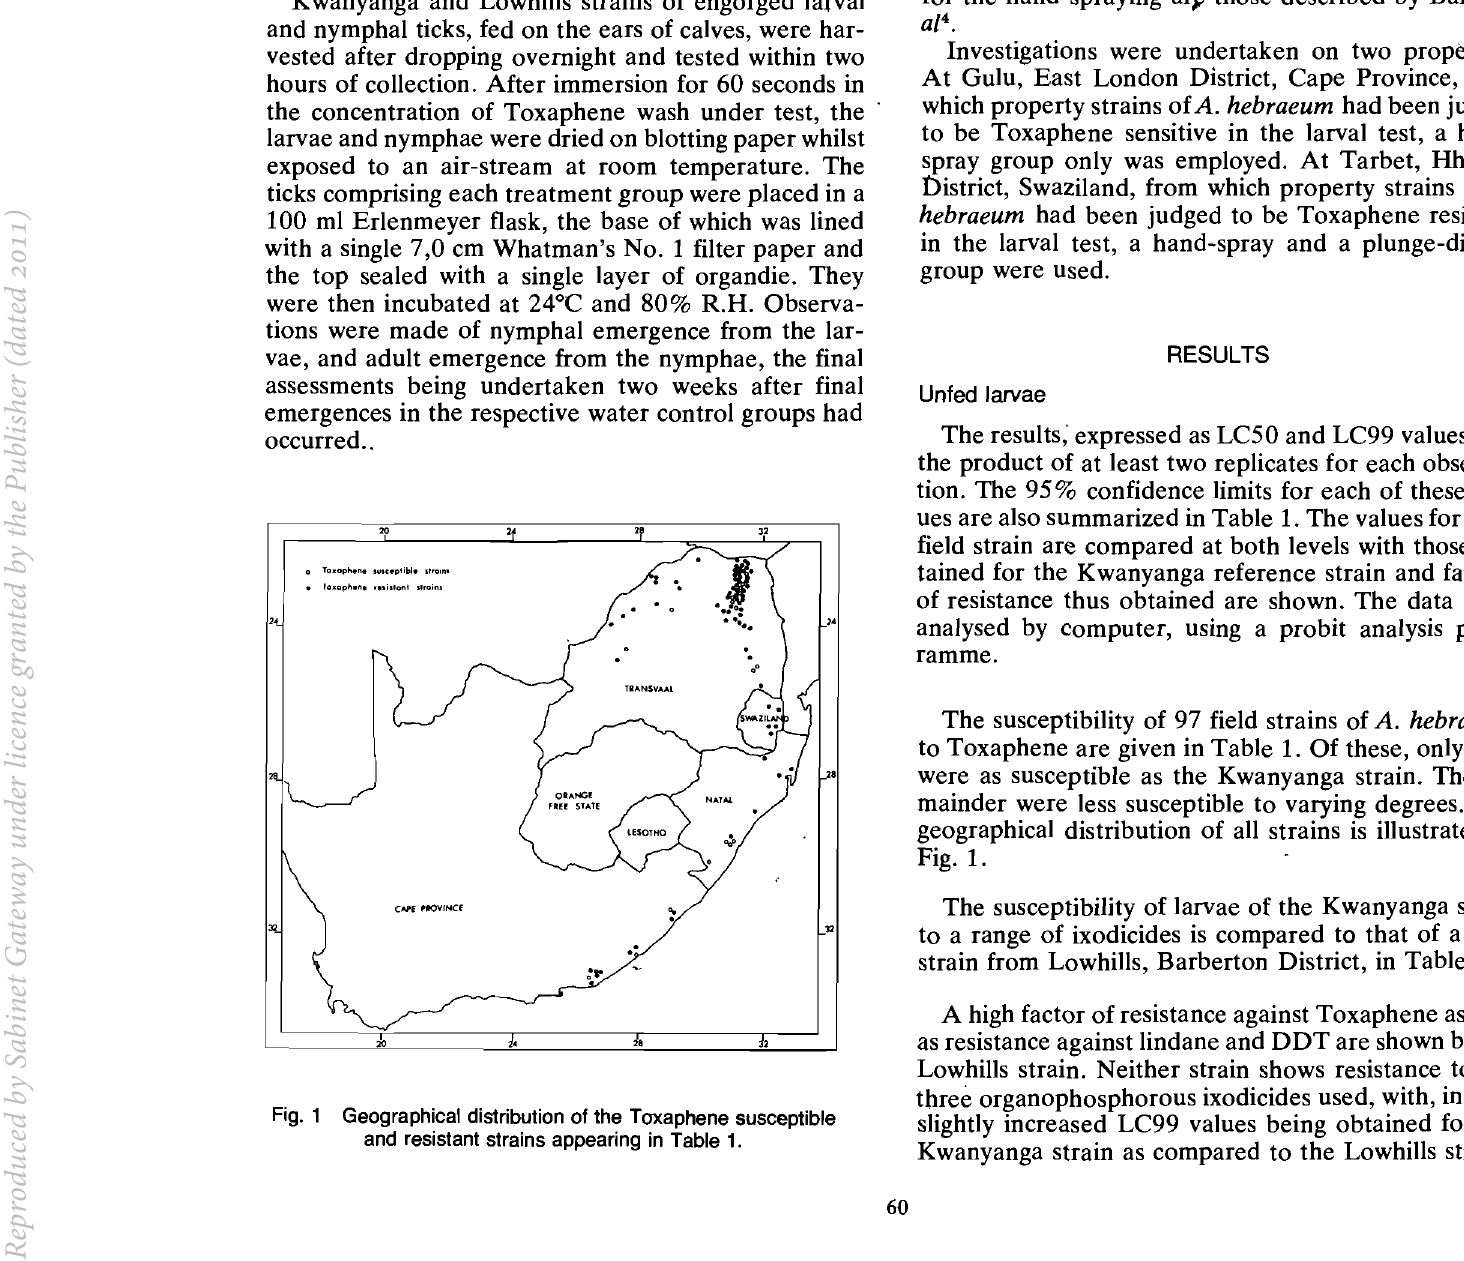
Fig. 1 Geographical distribution of the Toxaphene susceptible and resistant strains appearing in Table